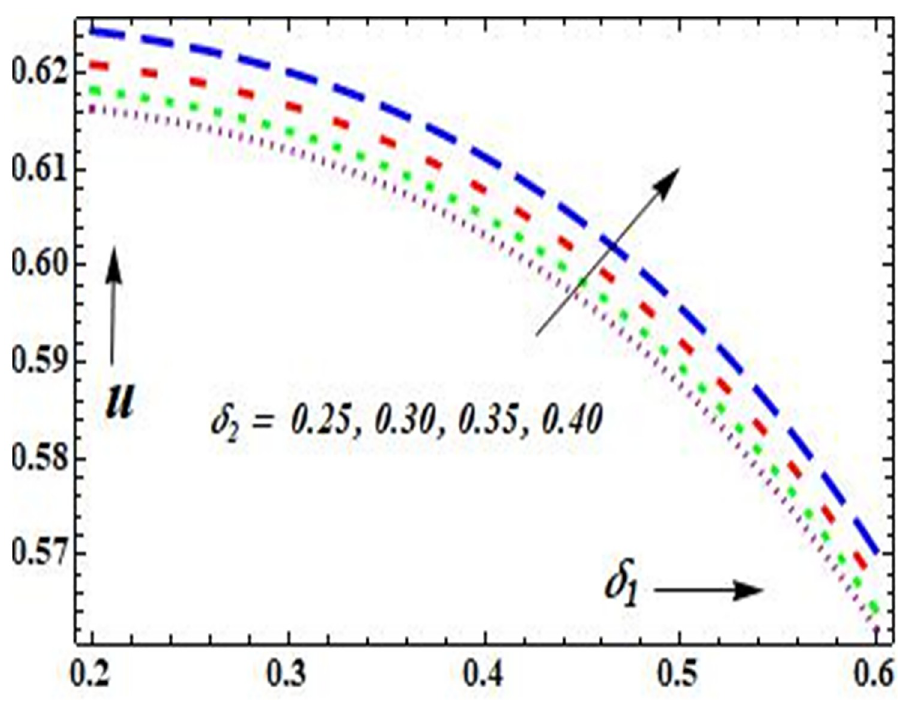
Fig 18. Plot of u on δ 1 and δ 2 with ϕ ¼ π